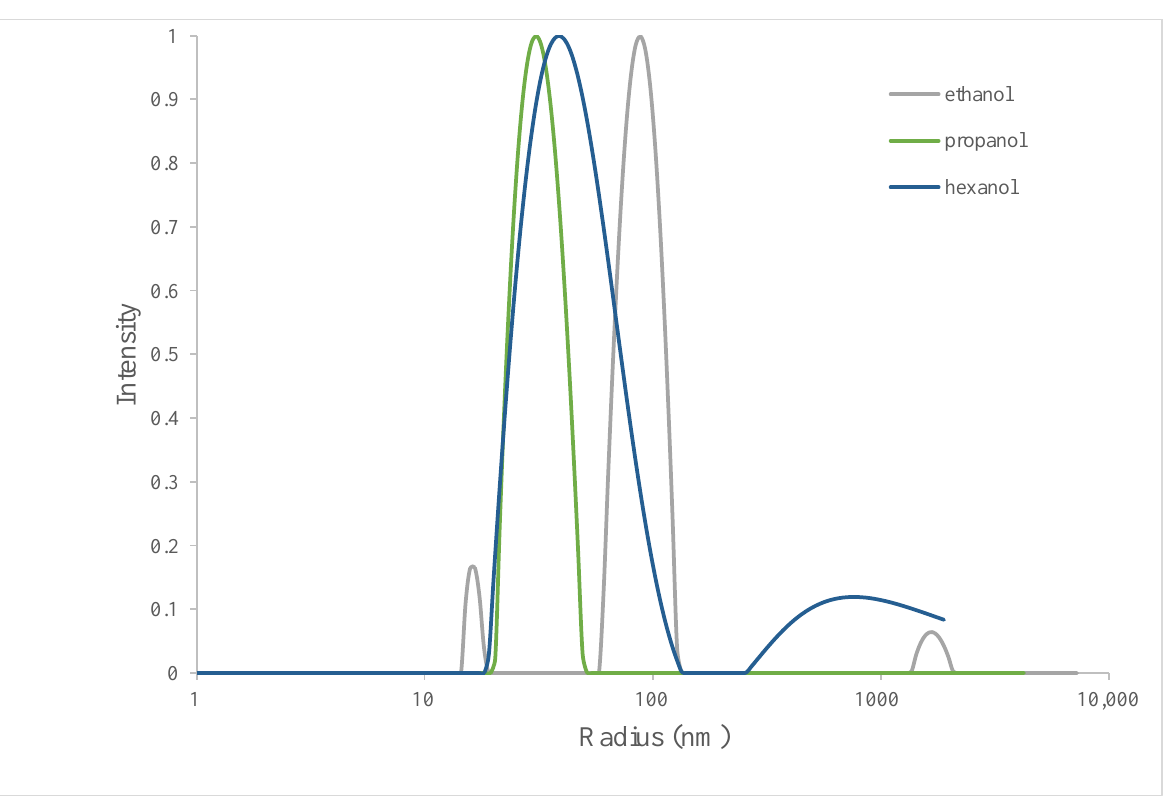
Figure 6. Effect of alcohol type on palladium particle size distribution in i -Pd(OAc) 2 (TPPTS) 2 after 24 h of reaction. Impregnation conditions: i -Pd(OAc) 2 (TPPTS) 2 (10 µ mol, Pd), 5 mL alcohol, 60 ◦ C, 1 atm